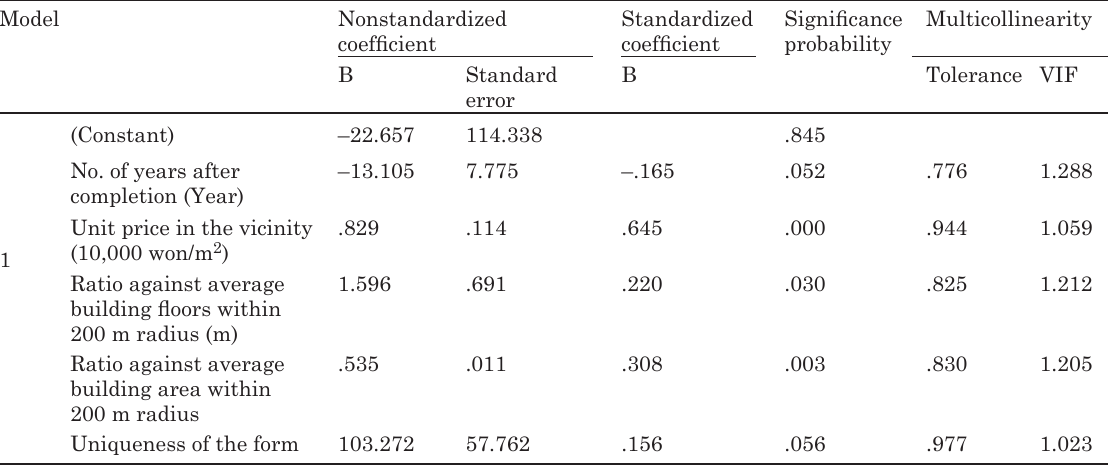
table 9. results of regression